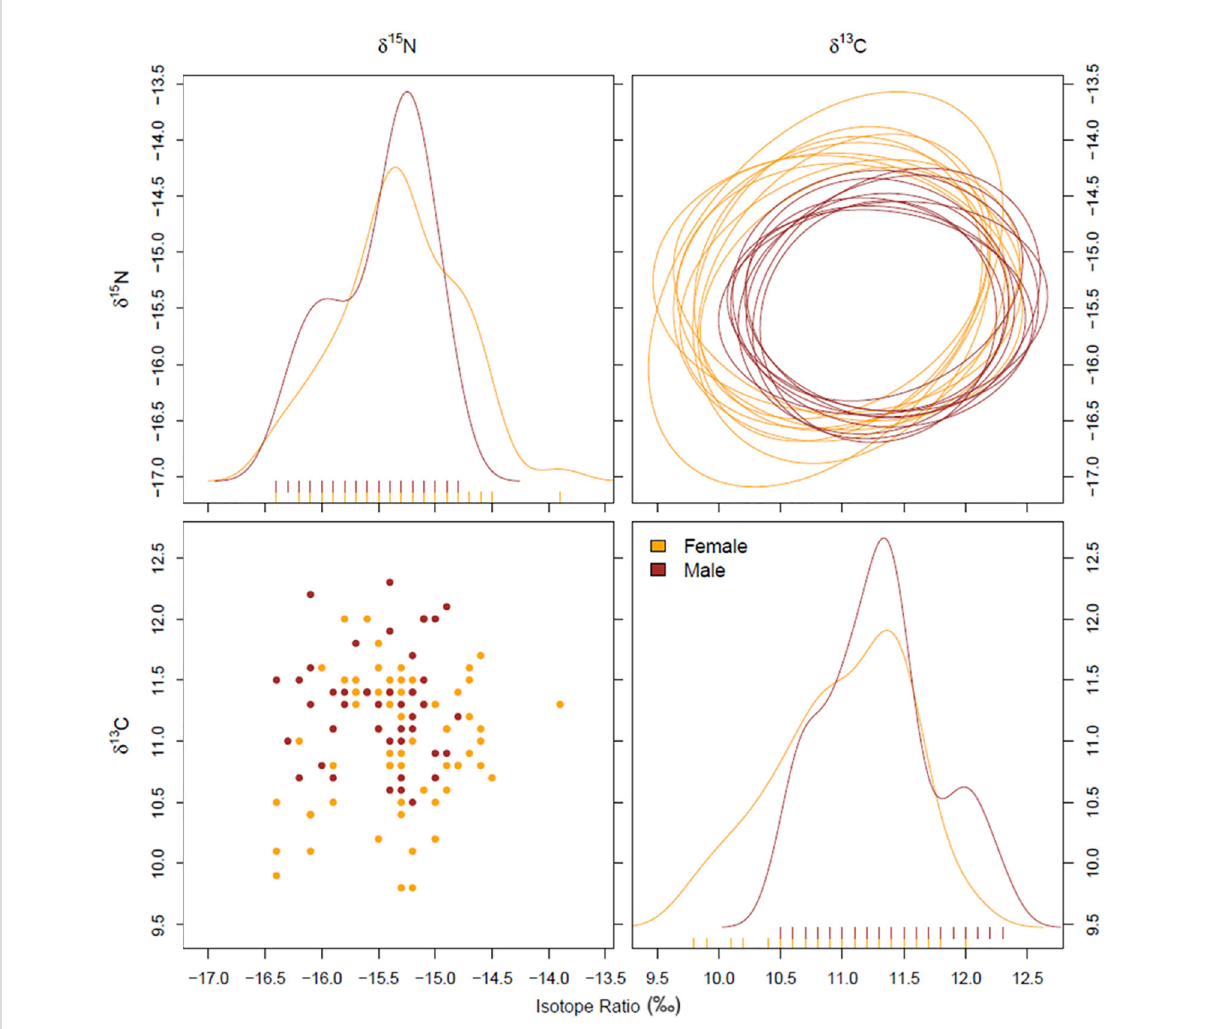
FIGURE 3 Global assessment – Niche plots (95% alpha) (A - d 15 N; D - d 13 C), density distributions (B) , and raw data (C) for each pairwise combination of isotope ( d 13 C and d 15 N) data for S. acus males and females.